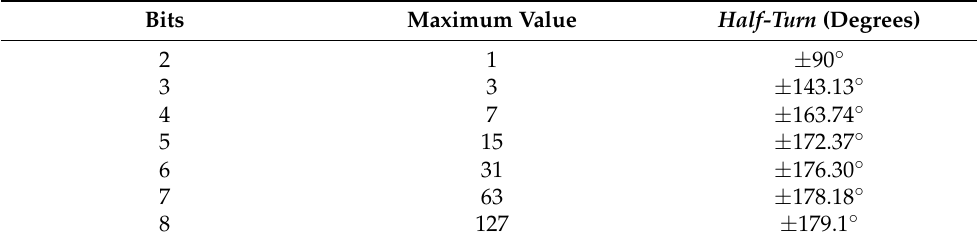
Table 1. Relation between bits for the integer part and half-turns in degrees.